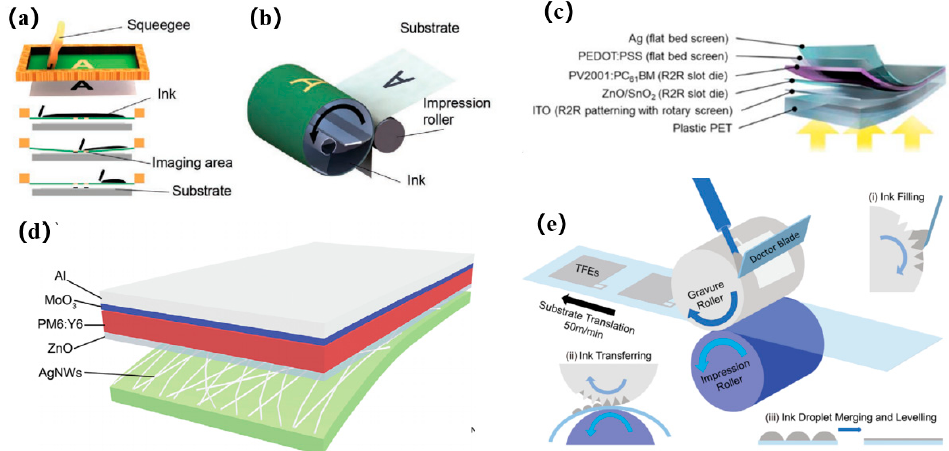
Figure 11. Schematic diagrams of ( a ) Flatbed screen printing, ( b ) Rotary screen printing. Adapted with permission from Ref. [112]. Copyright 2016 Wiley–VCH. ( c ) Fully roll-to-roll flexible device, ( d ) Device structure of the 1 cm 2 flexible OSCs. Adapted with permission from Ref. [119]. Copyright 2020 IOP Publishing Ltd. ( e ) Silver nanowire electrodes fabricated by high-speed gravure printing process. Adapted with permission from Ref. [126]. Copyright 2020 Wiley–VCH.